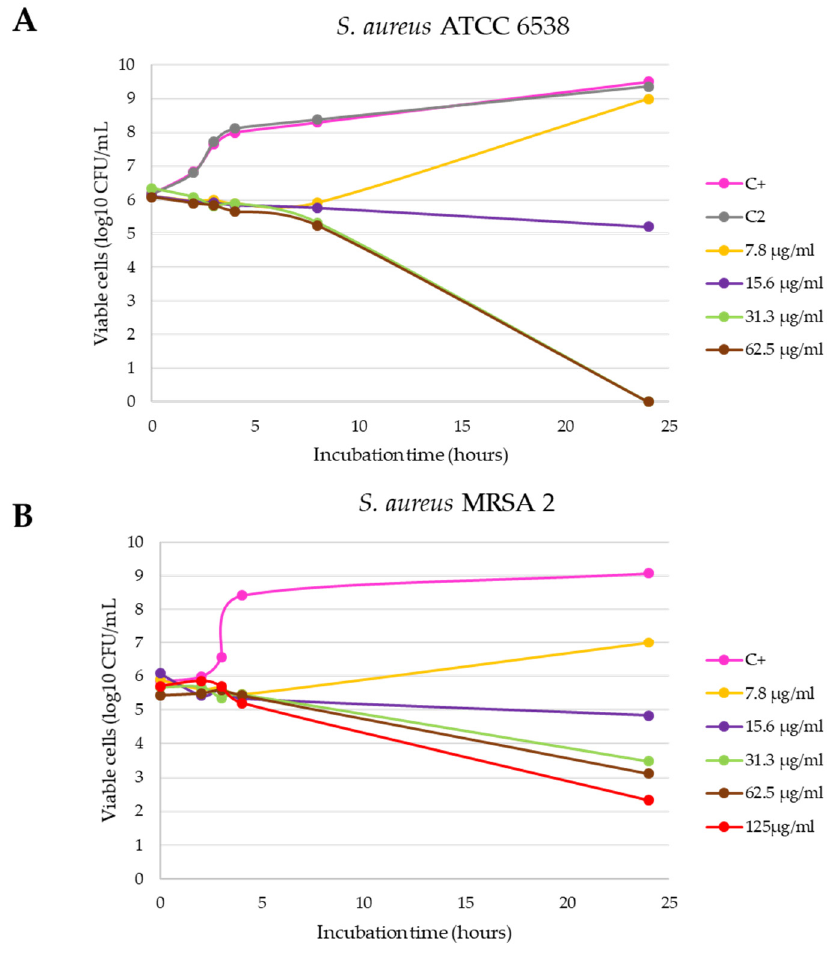
Figure 4. Inhibition curves of the C3-L1 product in liquid medium against S. aureus ATCC 6538 ( A ) and S. aureus MRSA 2 ( B